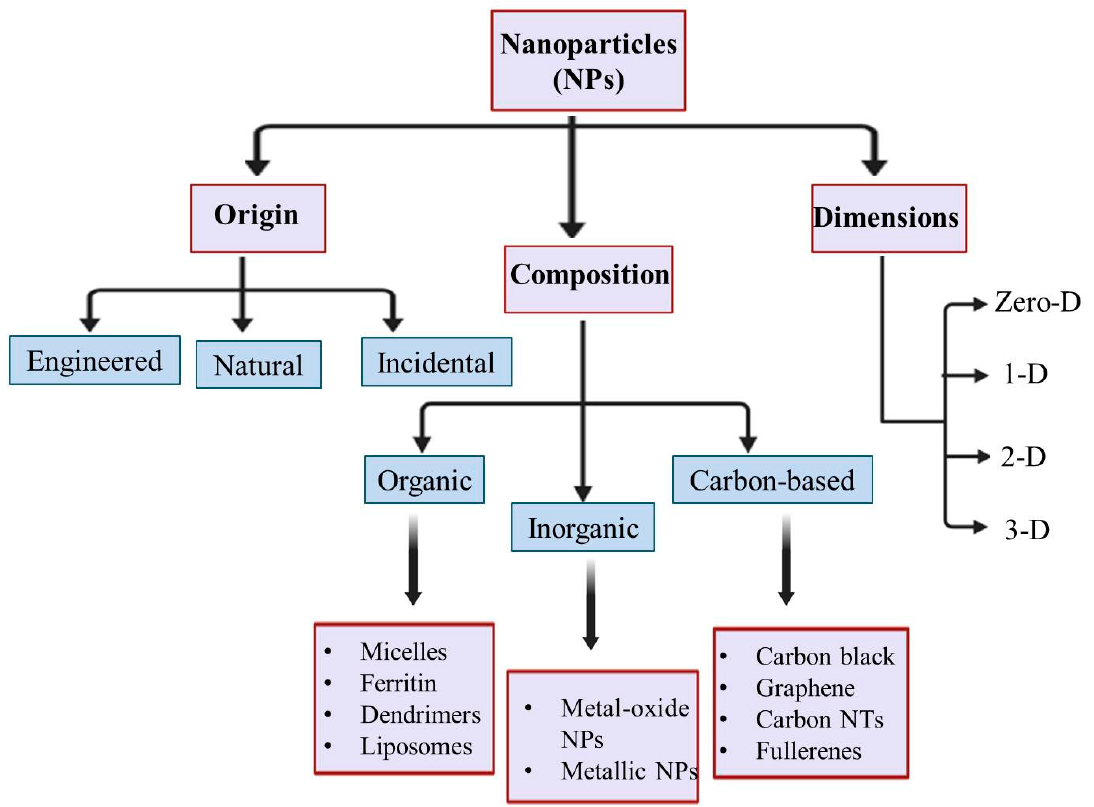
Figure 1. NPs (nanoparticles; usually ranging in size from 1 to 100 nm) classification on the basis of origin, dimensions, and structural configurations.